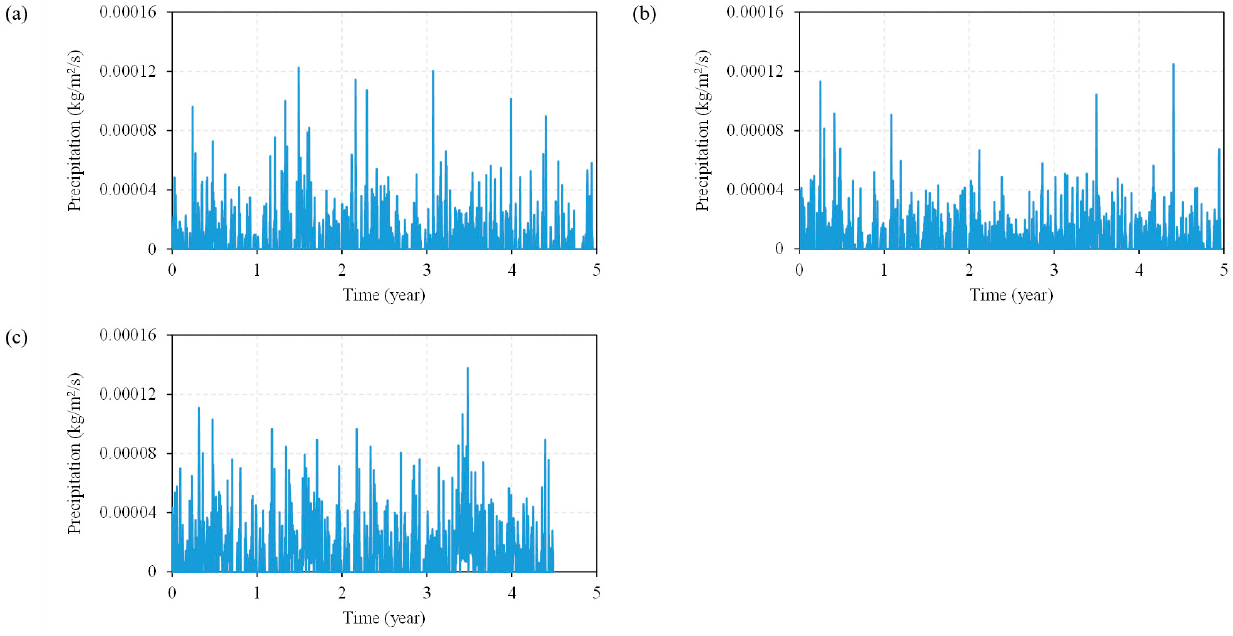
Figure 6. Examples of the mean precipitation: ( a ) BRU location ( b ) LT location ( c ) DP